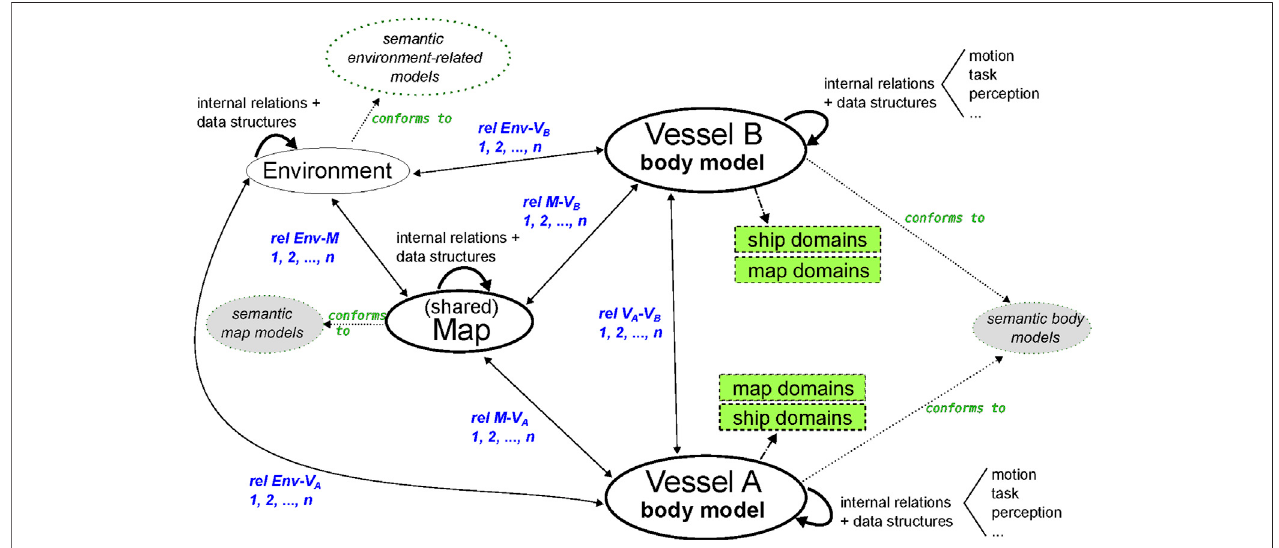
FIGURE 3 | High-level structure for model-integration and relations discussed throughout this paper, applied to a situation with two interacting vessels. Relations (rel) in blue. Grey ellipses (models) and green rectangles (ship and map-domains) are the main focus areas of this paper.